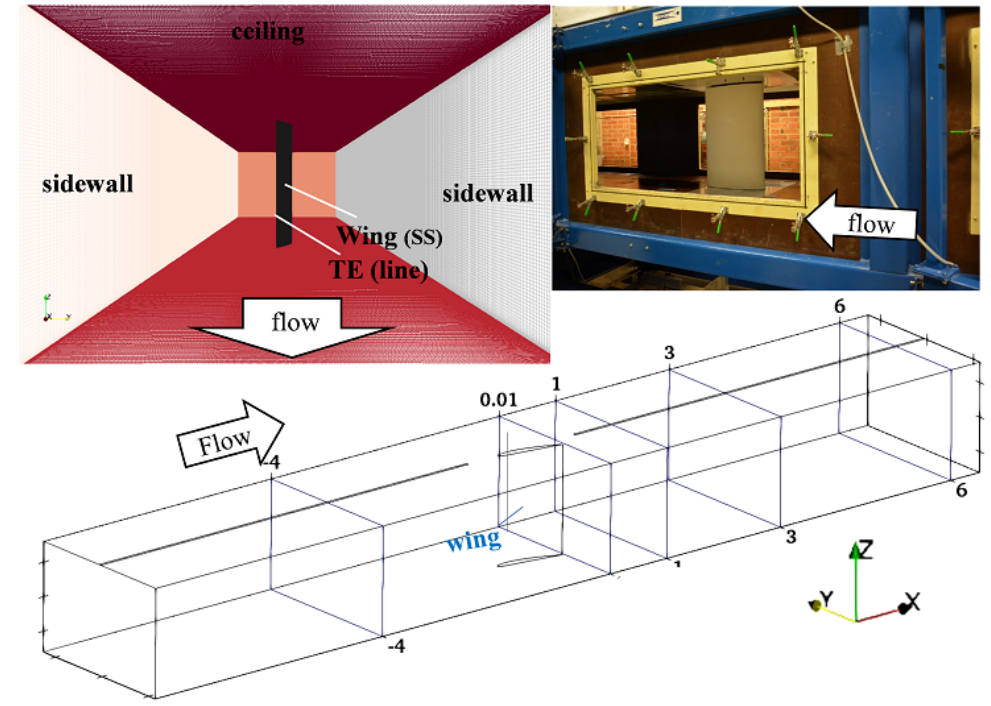
Figure 1. Computational domain according to the test section of MTL. X , Y , and Z refer to the streamwise, transverse, and spanwise direction, where the airfoil is located on the XY plane. The origin of the coordinate system is on the TE and at the mid-height section. Selected normal planes are shown at certain streamwise locations: X = − 4C, 0.01C, 1C, 3C, 6C. The airfoil chord length C is 0.5